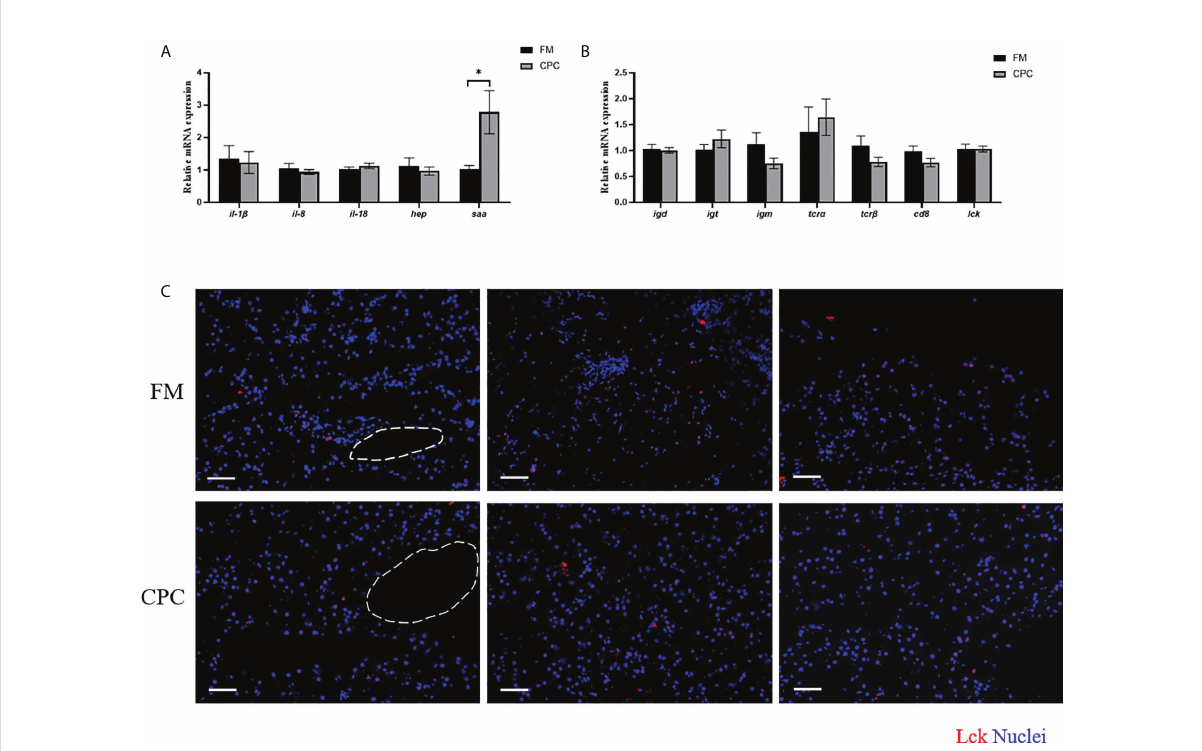
FIGURE 3 Largemouth bass hepatic immunity was not signi fi cantly affected after CPC replacing fi shmeal. (A) The relative mRNA expression levels of genes involved in innate immunity ( il-1 b , il-18, il-8 , hep and saa ) in the liver of juvenile largemouth bass in both FM group and CPC group. (B) The relative mRNA expression levels of genes involved in adaptive immunity ( igm, igd, igt , tcr a , tcr b , lck , and cd8) in the liver of juvenile largemouth bass in both FM group and CPC group. (C) Immuno fl uorence results of T cells in liver of juvenile largemouth bass in both FM group and CPC group with antibody against Lck. Scale bars, 100 m m. All data was analyzed with student ’ s t-test and data are means ± SD (n = 6). *P< 0.05; **P< 0.01; ***P<